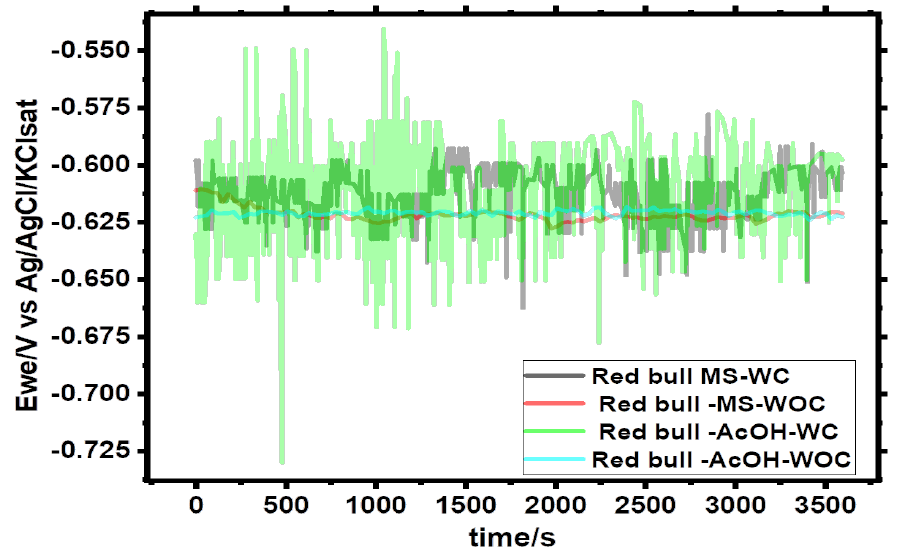
Figure 2. Open circuit potential of Red Bull samples with (WC) and without (WOC) an organic coating in main (MS) and acetic acid (AcOH) [0.1 M] solutions; Ewe: working electrode potential.